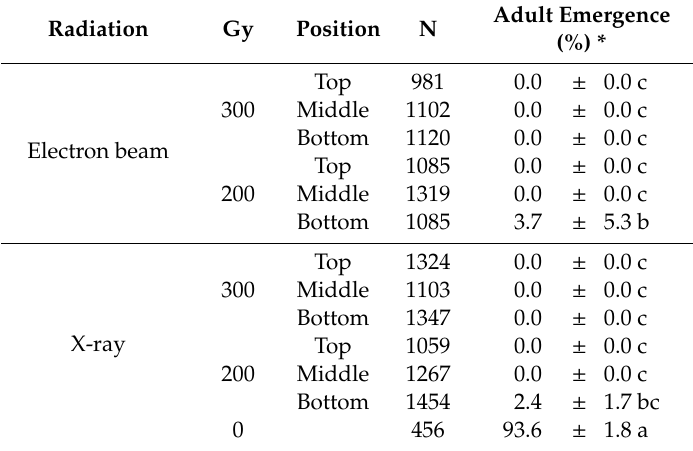
Table 7. Mean ( ± SD) adult emergence rate from nymph (%) of T. vaporariorum at three di ff erent locations (top, middle, and bottom) in boxes filled with strawberry fruits irradiated by 200, 300 Gy of electron beam and X-rays.